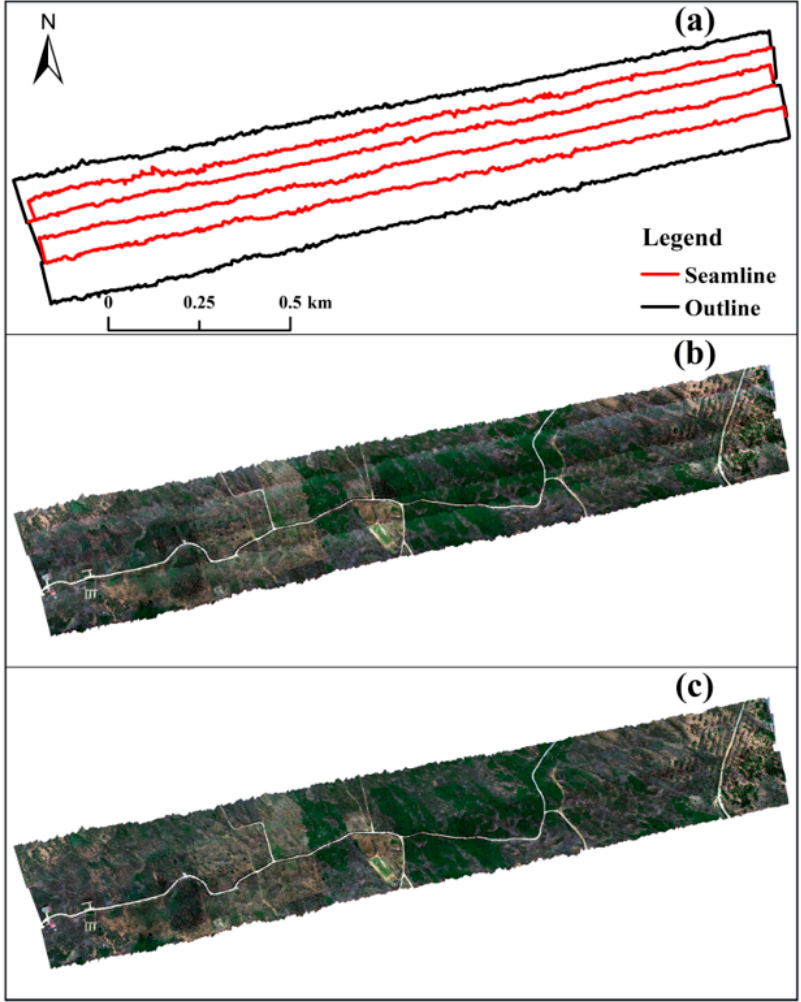
Figure 14. True color composite images of airborne hyperspectral data collected on 16 August 2021 before and after correction. ( a ) Outline and seamline of the hyperspectral mosaic image, ( b ) Uncorrected mosaic, ( c ) RA-TOC-CA corrected mosaic.